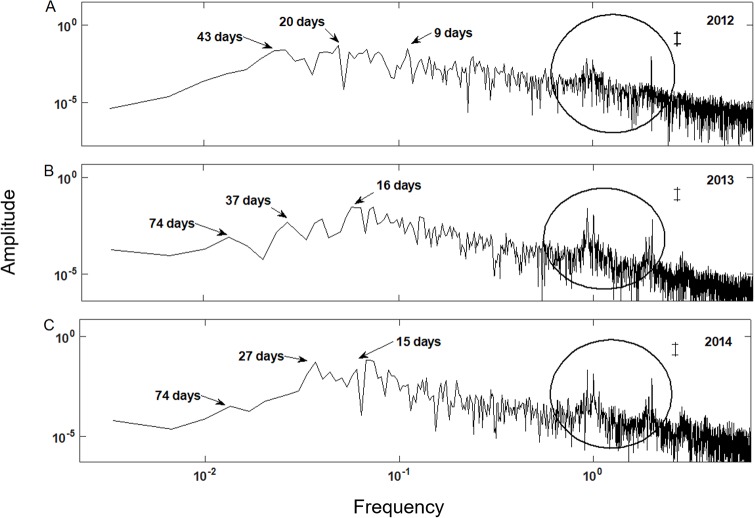
Dominant frequency spectrum for the water level data of site 1 in 2012 (A), 2013 (B) and 2014 (C). The circle indicates the diurnal (left hand peak) and semidiurnal (right hand peak) tides.The black bar indicates the confidence interval.